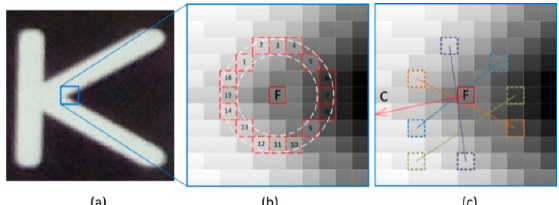
Figure 4. ( a ) The highlighted patch contains the pixels used for the keypoints detection; ( b ) The point F is a candidate keypoint [19], surrounded by a circle of sixteen points; ( c ) A number of pair-wise intensity comparisons describe point F [20], FC is the vector from keypoint F to the centroid C of the patch.